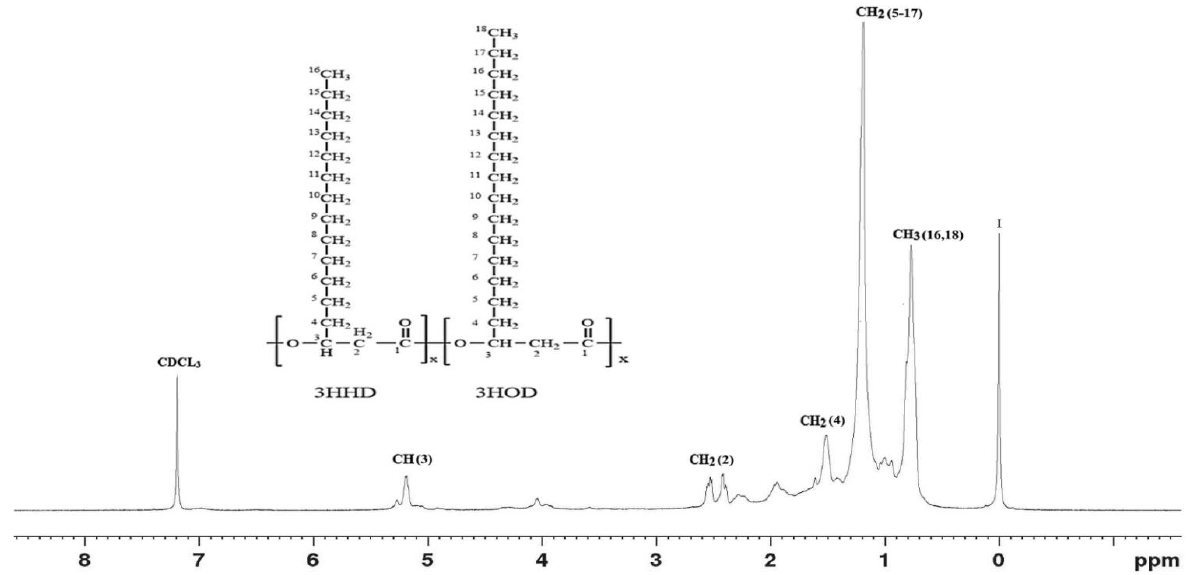
Figure 2. The 1 H NMR spectrum of the PHA produced by Acinetobacter sp. strain AAAID-1.5 in a biosynthesis medium containing used transformer oil as a carbon source.